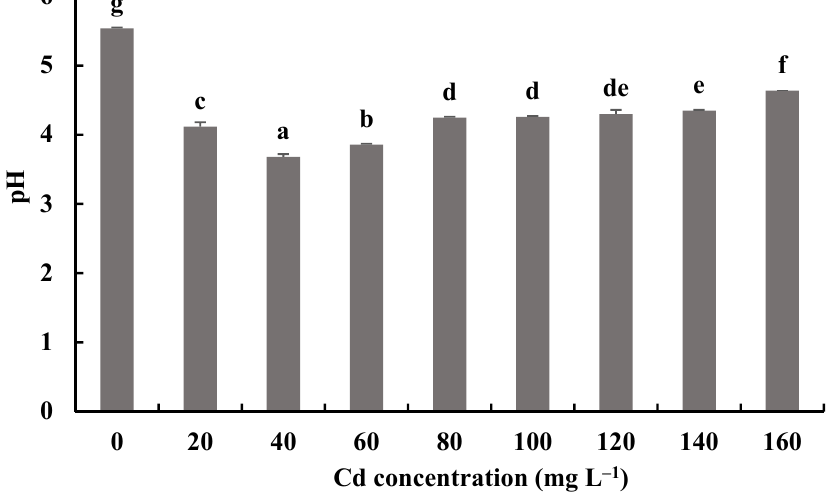
Figure 9. Effects of different concentrations of Cd 2+ on the pH of a fermentation mixture of H. chrysospermus. Different letters indicated significant difference ( p < 0.05).